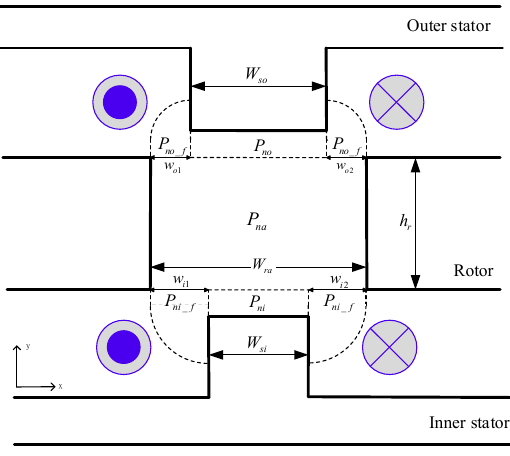
Figure 8. Permeances between stator and rotor at completely unaligned position.